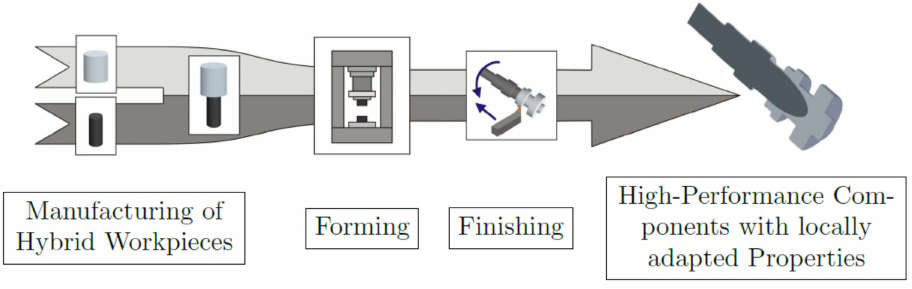
Figure 1. Tailored forming process chain